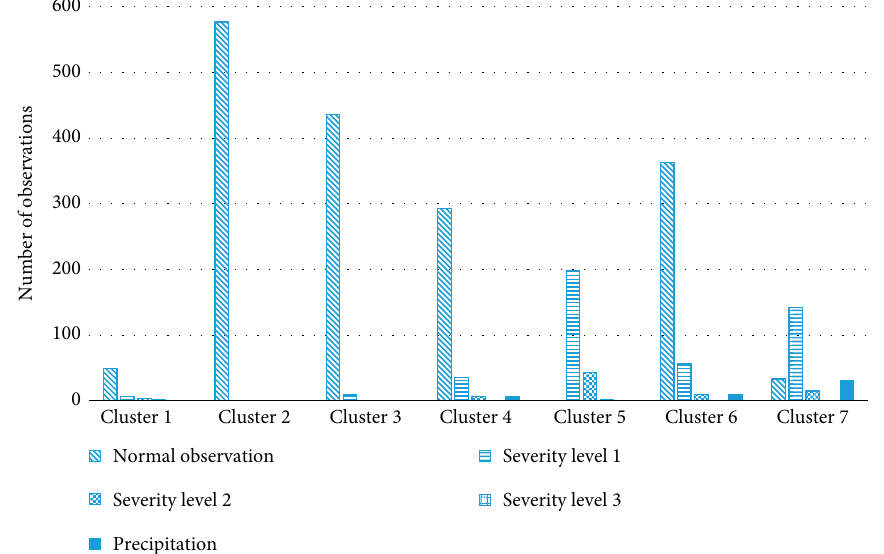
Figure 7: Observations with different levels of severity and precipitation in the clusters identified by the K-medoids